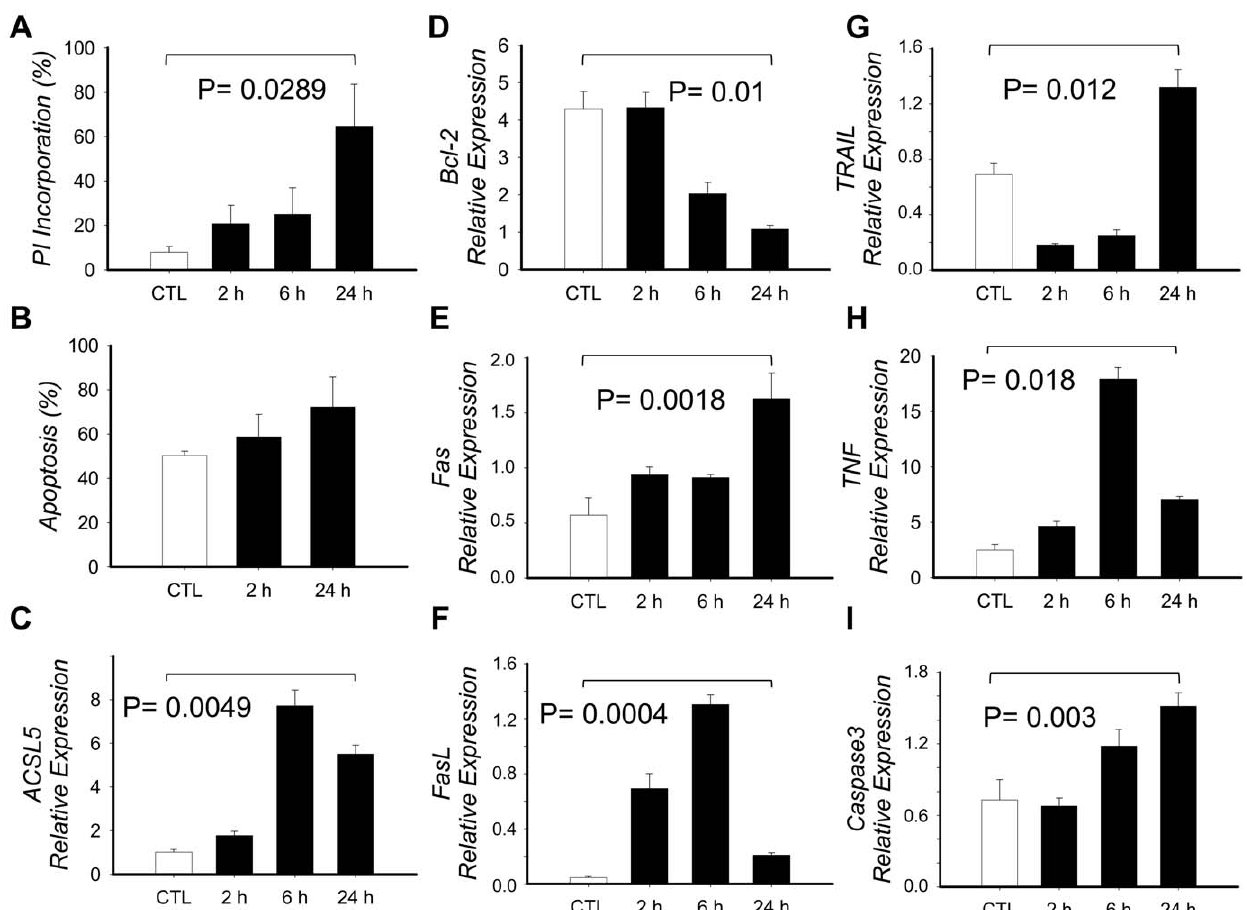
Figure 2. Effect of PMA + Io activation in PBMCs. PBMCs from healthy controls were obtained and cultured in the presence or absence of PMA + Io for up to 24 h. A) Cells were collected at defined times, washed with PBS, fixed with 70% Ethanol, stained with Propidium Iodide (PI) and analyzed in a FACSCaliburTM flow cytometer to determine the apoptotic hipodiploid cell fragments (defined as percentage of PI incorporation). B) Cells were washed twice with PBS and double stained with Annexin V and PI, then analyzed by FACS to determine the percentage of apoptotic cells (Annexin V positive and double positive cells). C–I) Total RNA was extracted, cDNA synthesized and qRT-PCR implemented to determine mRNA expression. Results are given by means of three independent experiments and the bars show the standard deviation. P-value has been calculated with the paired Student t test.